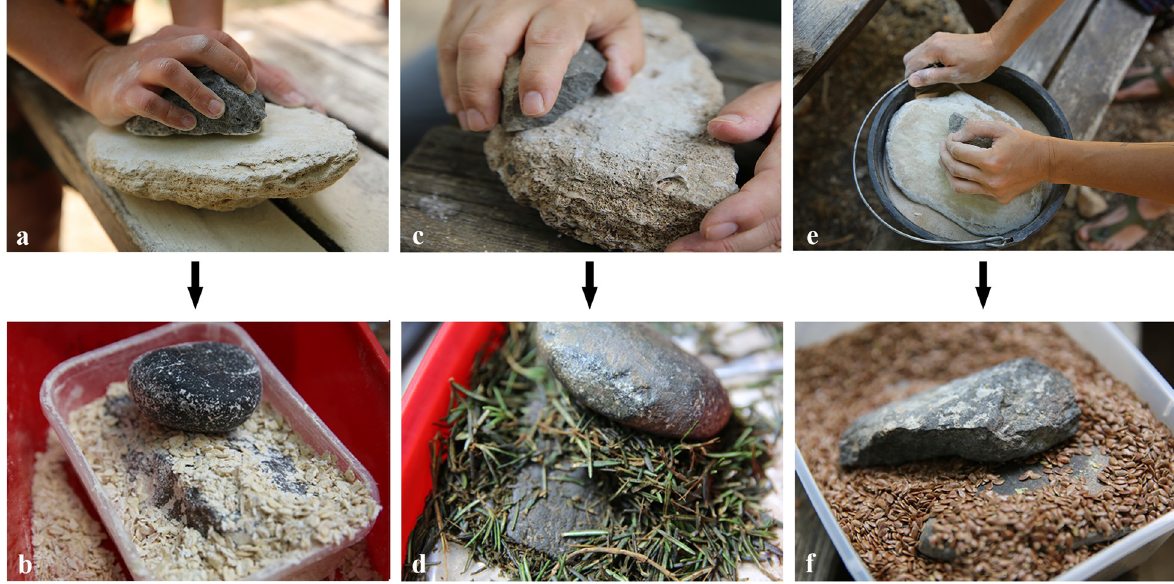
Fig 4. Experimental program. (a) Abrading basalt against aeolianite; (b) Grinding oat flakes on the surface prepared by abrading the aeolianite; (c) Abrading basalt against beachrock; (d) Grinding rosemary leaves and stems on the surface prepared by abrading against beachrock; (e) Abrading basalt against aeolianite with sand; (f) Grinding flax seeds on the surface prepared by abrading against aeolianite with sand (see also Table 2).